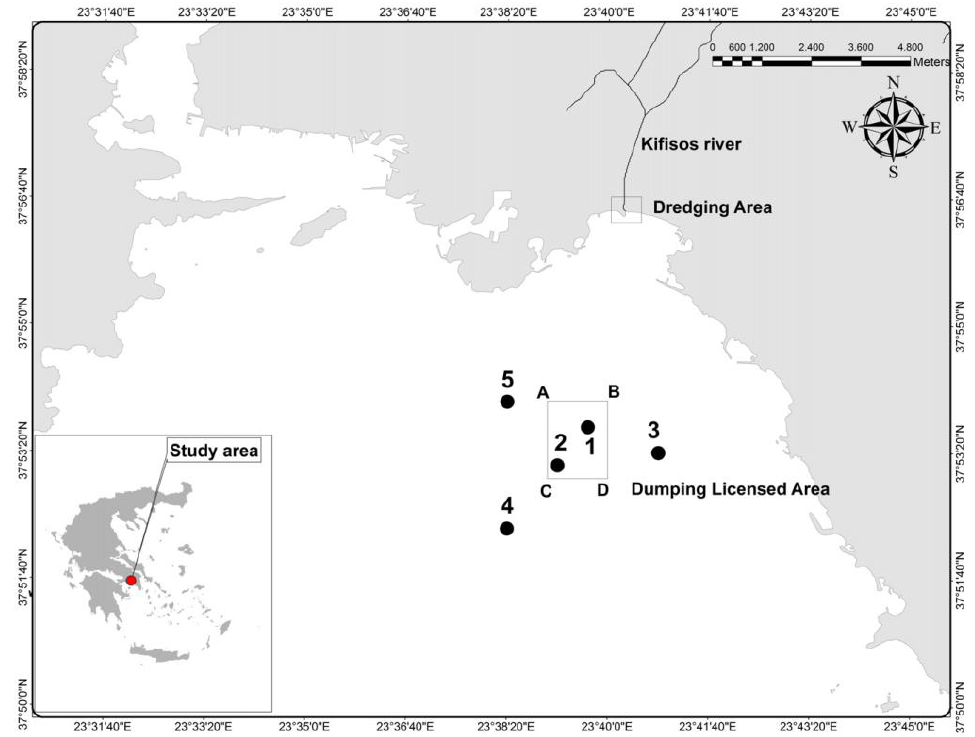
Figure 1. Map of the study area with the licensed area for the dumping of dredge spoil (rectangle ABCD). The sampling stations with numbers 1 to 5 represent stations DSS1 to DSS5, which were located within the dumping site (DSS1 and DSS2) and in the nearby site (DSS3, DSS4 and DSS5).